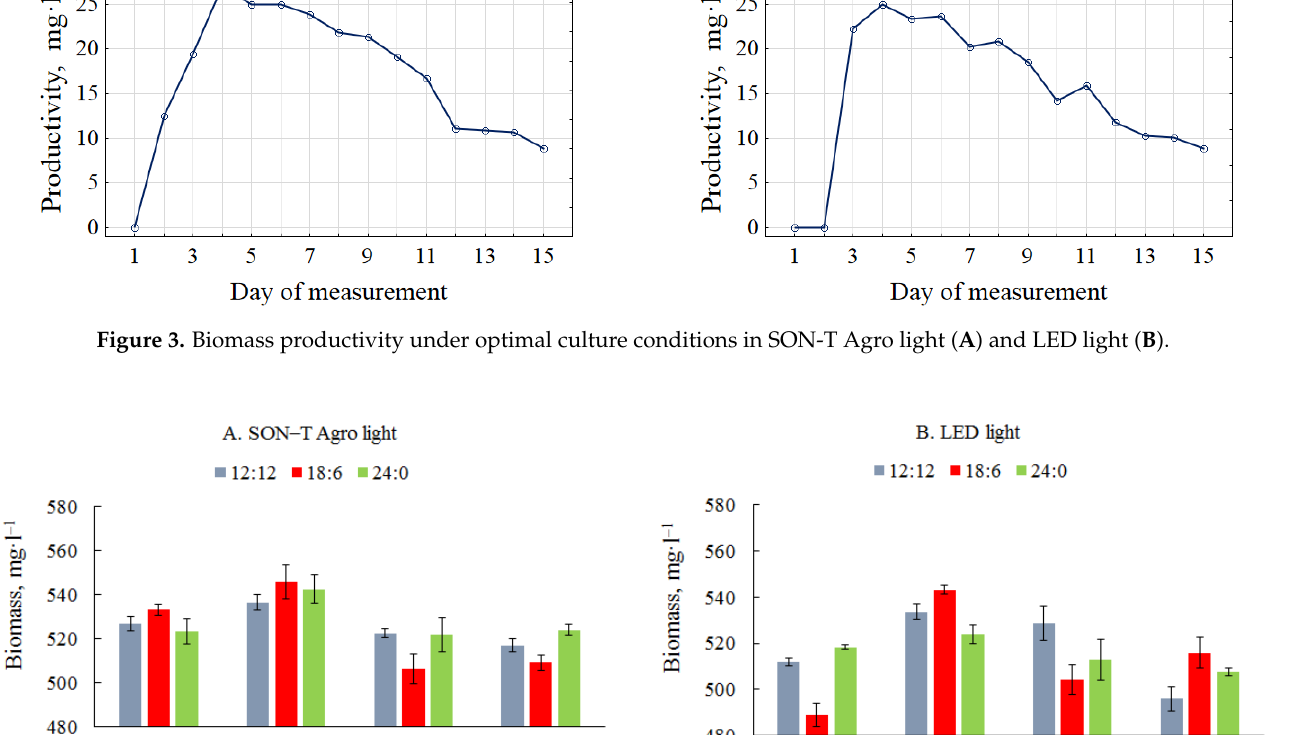
Figure 4. The average amount of microalgae biomass in SON-T Agro light ( A ) and LED light ( B ) during different light:dark cycle.